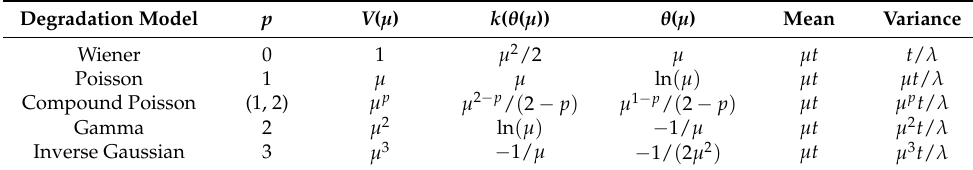
Table 1. Five well-known TED